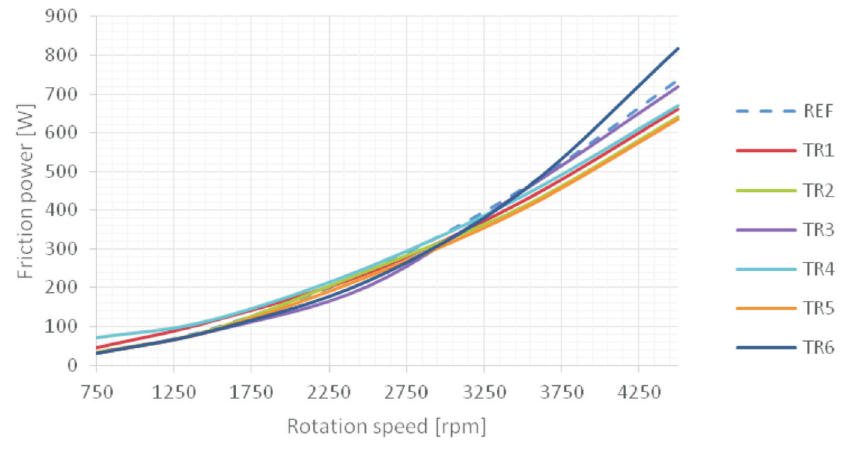
Fig. 6. Simulation results for the CI